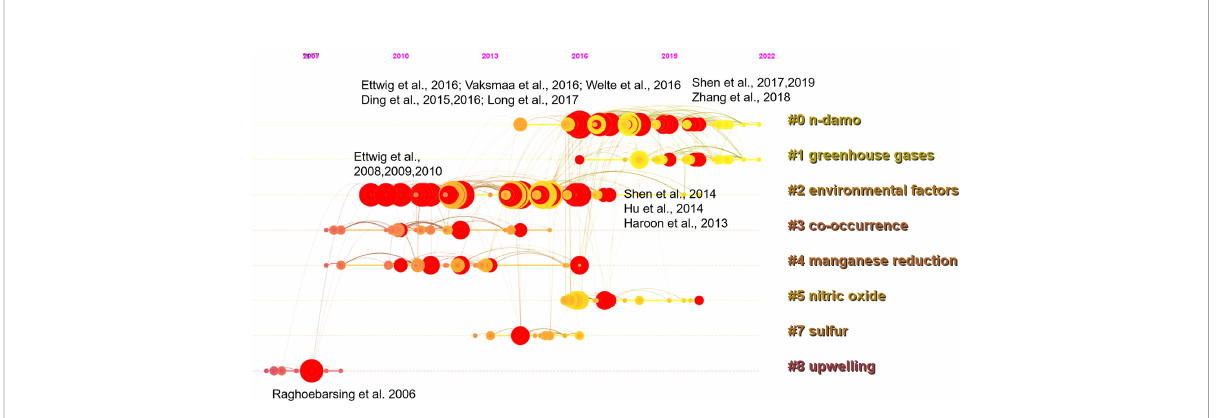
FIGURE 3 A timeline view of the co-citation network with the 8 largest clusters. Red circles represent references with citation bursts; the size of the circles re fl ects citation counts; links between nodes suggest that they were co-cited by citing